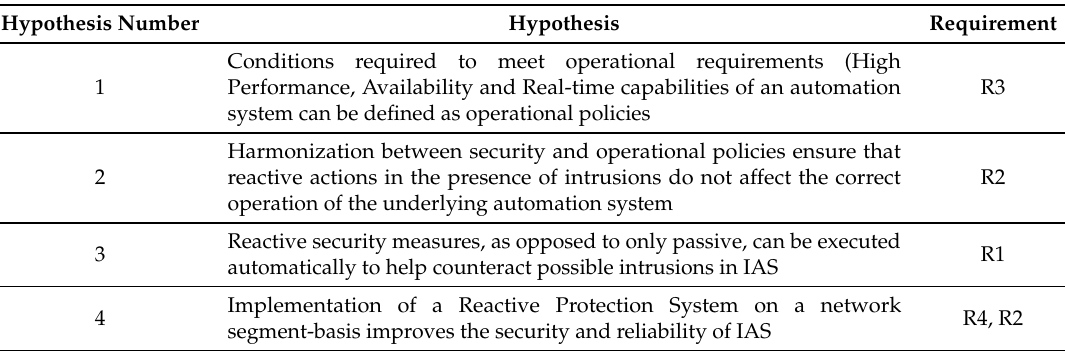
Table 6. Mapping between hypotheses and